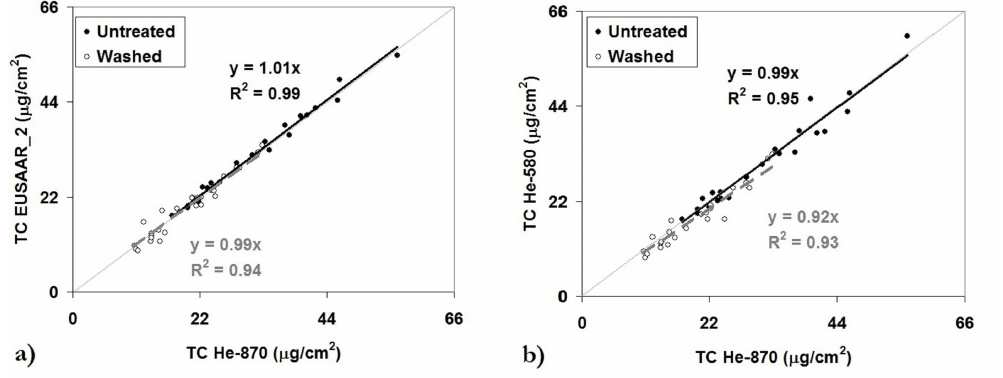
Fig. 1. Comparison between the TC results obtained by EUSAAR 2 and He-870 (a) , and He-580 and He-870 (b) on untreated and washed